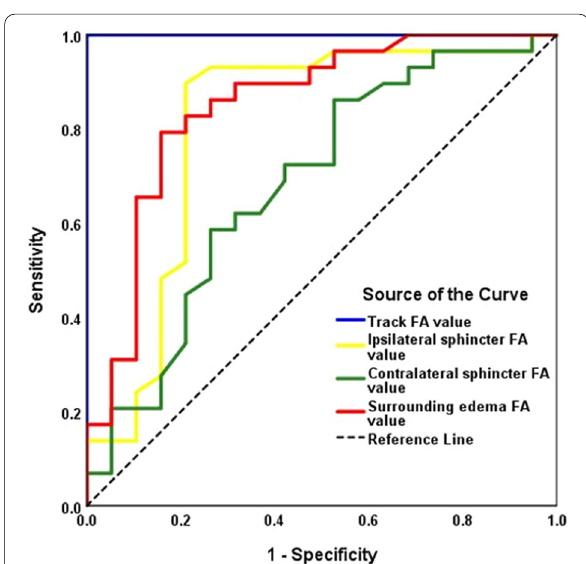
Fig. 4 ROC curve analysis for FA measures to differentiate active